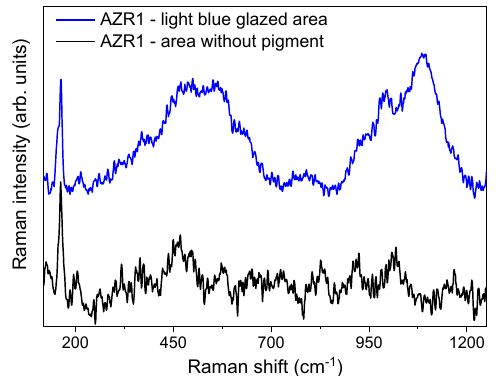
Fig. 4. Raman spectra collected on the light-blue glazed surface area and on the small area without pigment of sample AZR1. In the inset, a magnification of the low-frequency region is shown, in order to highlight the double-peak centred at ~ 160 cm -1 .  exc = 633 nm .